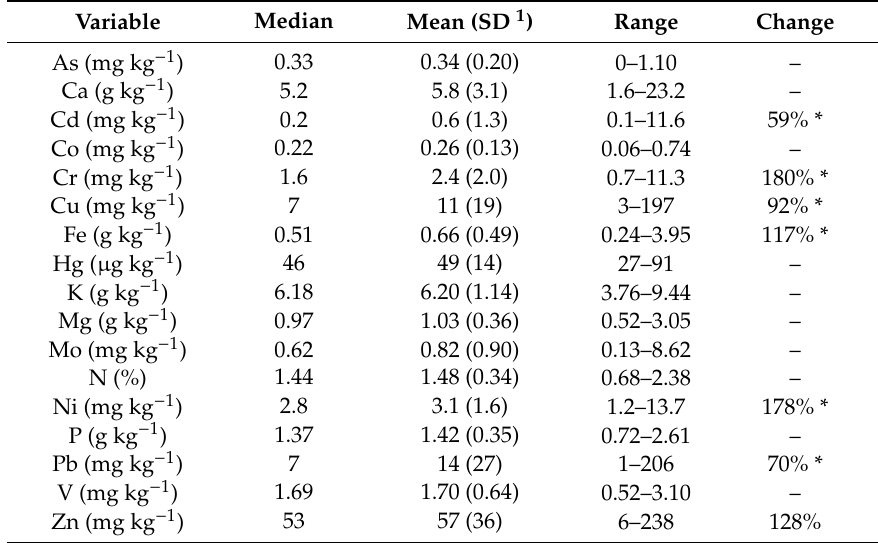
Table 1. The concentration of elements in moss in Poland (N = 117) in 2015 and its change between 2001–2015 expressed as percentage of the 2001 median (values below 100% represent a decline, values above 100% represent an increase in the study period; asterisks indicate statistically significant changes according to the LME analysis; cf. Figure 2). The change was calculated only for the seven elements that were measured in both